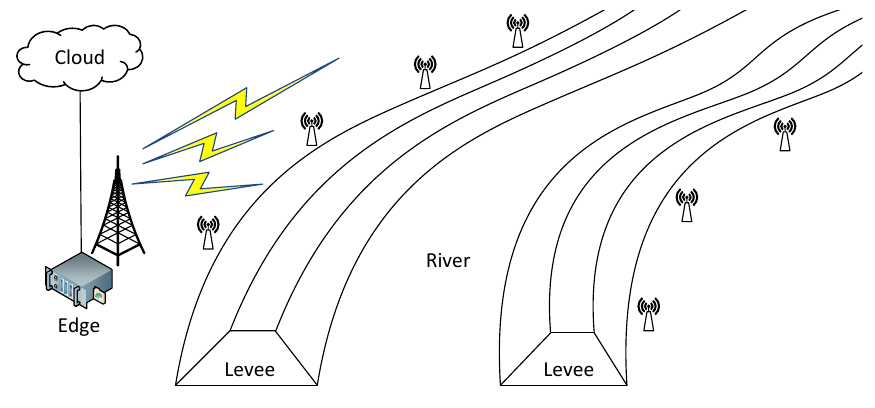
Figure 1. Levee monitoring